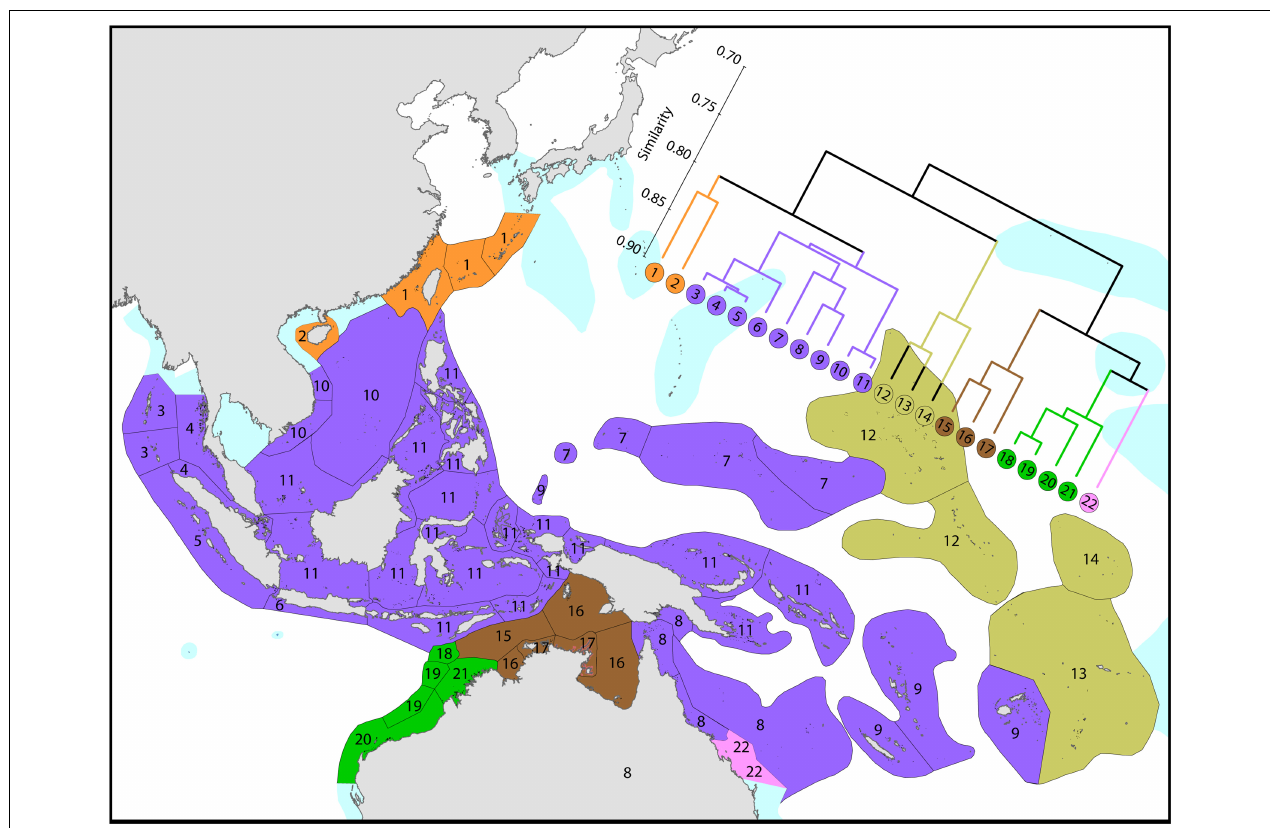
FIGURE 7 | Affinities of ecoregions in and around the Central Indo-Pacific. This dendrogram was produced by the progressive exclusion of outlying ecoregions; there were no internal exclusions. See Supplementary Material 1: “List of ecoregions and associated data” for number of species within ecoregions.